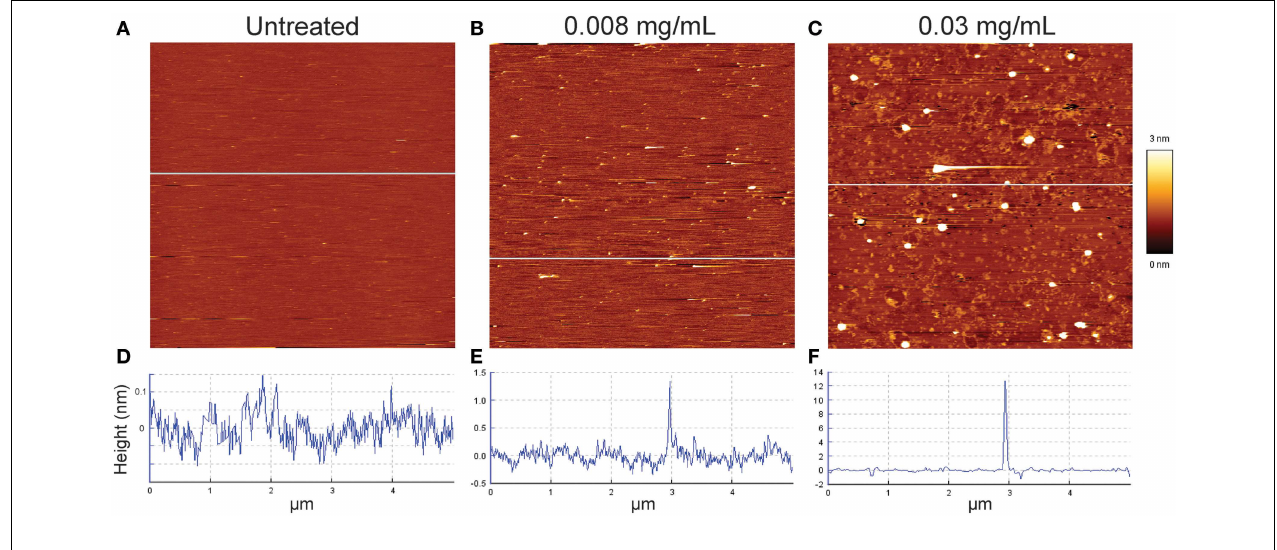
FIGURE 7 | Contact mode atomic force microscope height images of E. coli supported lipid bilayers before (A), and after isoeugenol treatment (B,C). Untreated E. coli lipid (A,D) was imaged in MES-buffer (pH 6.0) at 37 ◦ C, and subsequently treated with either low (B,E) or high (C,F) concentration isoeugenol as evaluated on calcein leakage ( Figure 5 ) for an